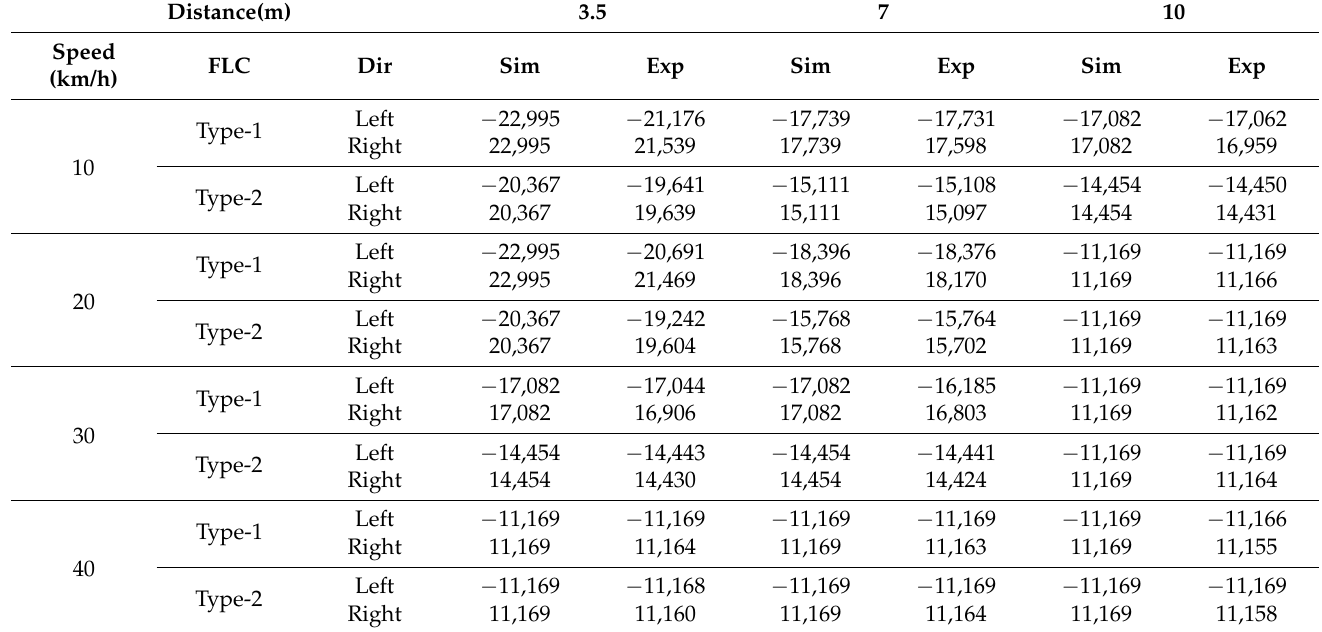
Table 3. Comparison between simulation and experiment output signal generated at a speed of 10 up to 40 km/h. (Dir = direction; Sim = simulation; Exp =